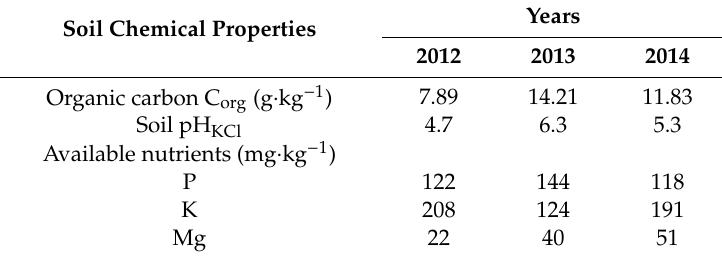
Table 1. Soil chemical properties at the experimental site.